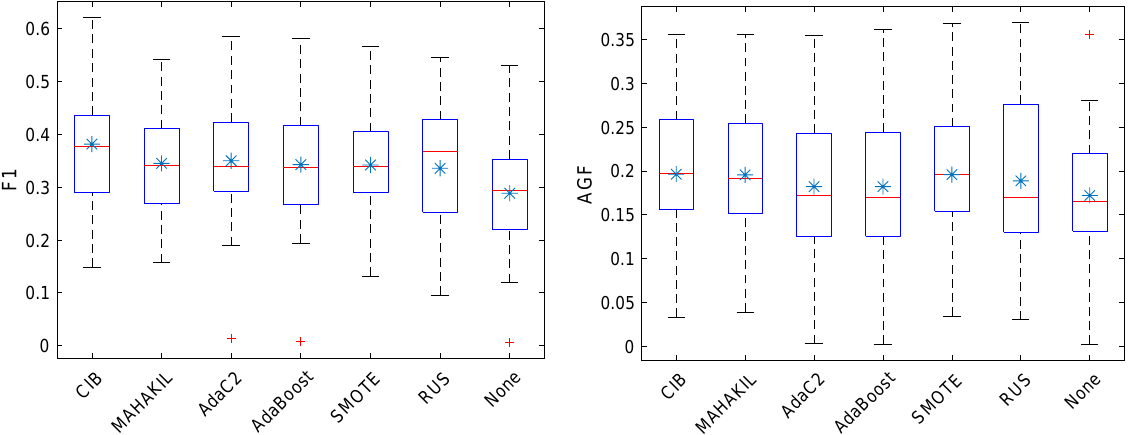
( a ) Boxplot of F 1 for all methods across all datasets.